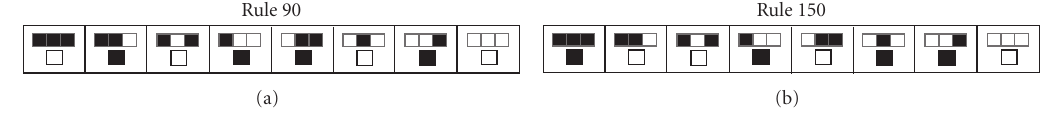
Figure 3: Graphical representations of CA rules “90” and “150” [6].